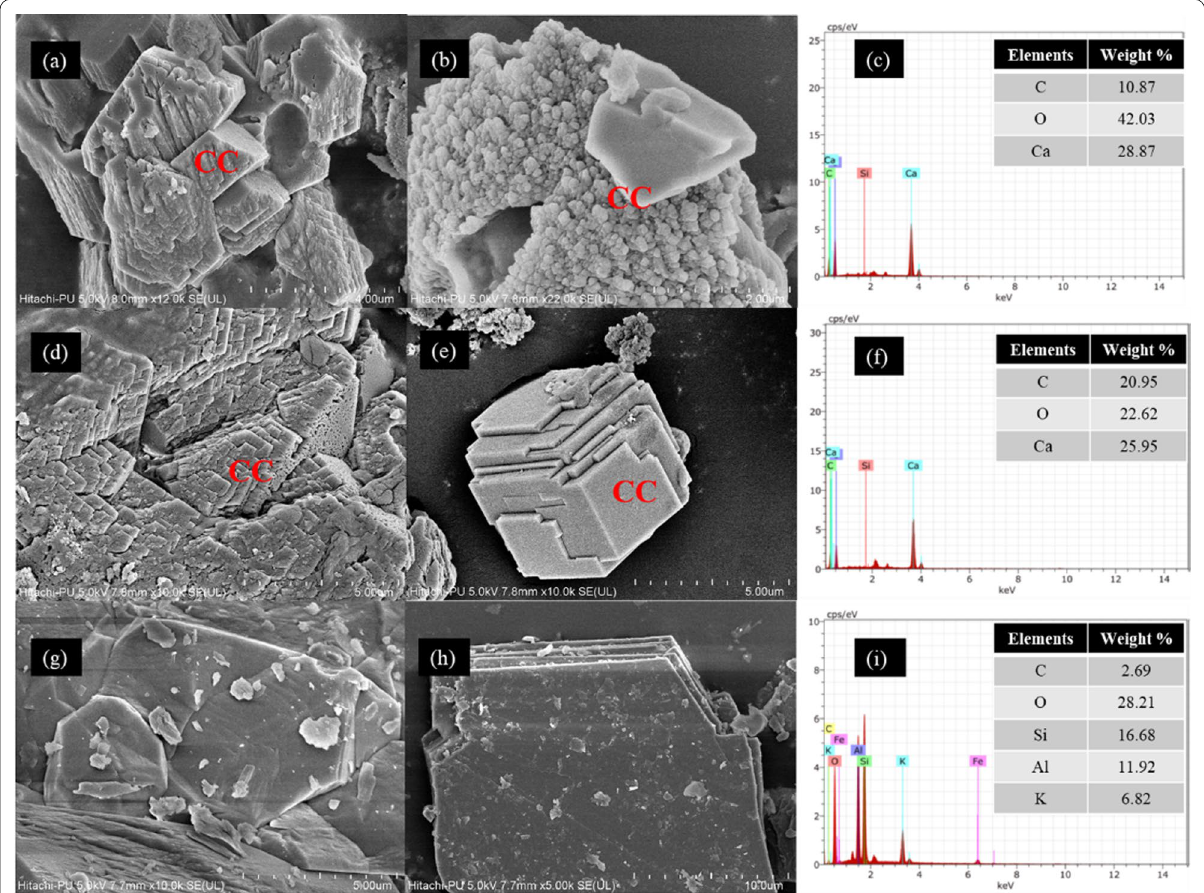
Fig. 4 SEM-EDX images represent CaCO 3 crystals (CC) precipitated on upper layer of sand column treated with live (LT) Synechocystis pevalekii cells ( a , b ), UV treated (UVT) S. pevalekii cells ( d , e ), and control ( g , h ). EDS analysis ( c , f , i ) was conducted on the whole